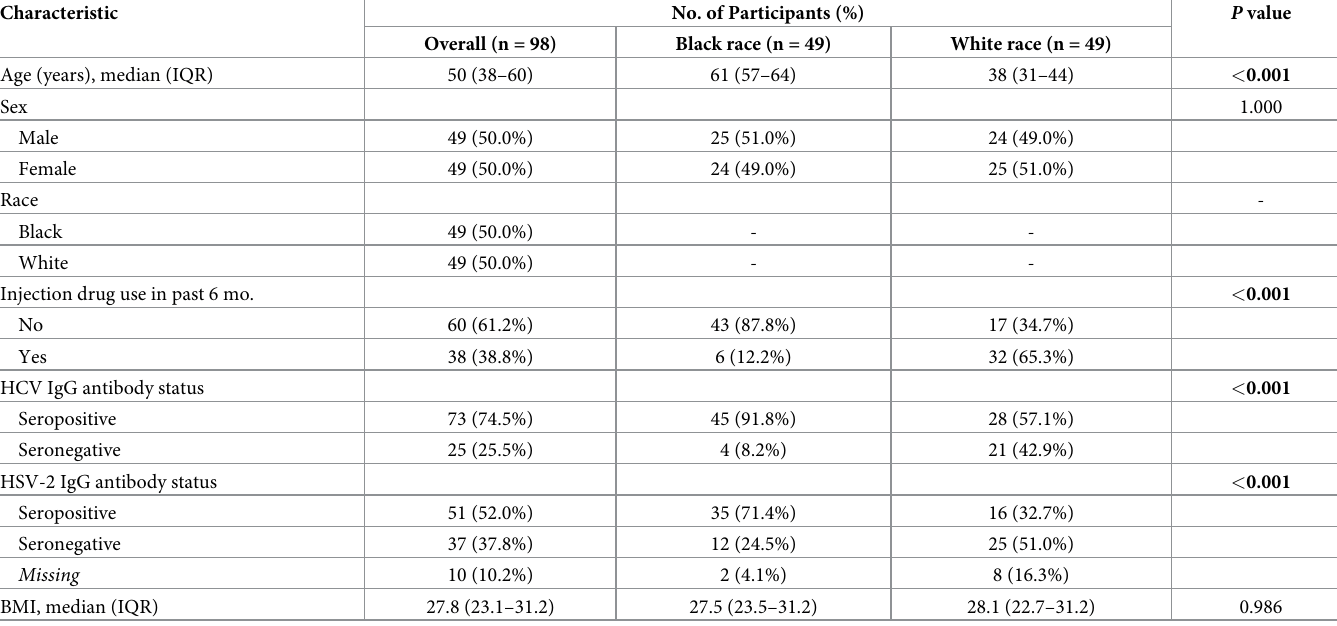
Table 1. Characteristics of the study population.